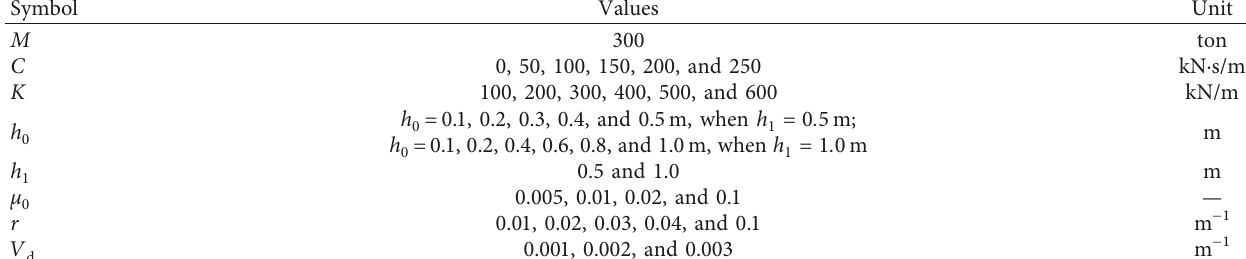
Table 3: Parameter values of the system in Figure 1.